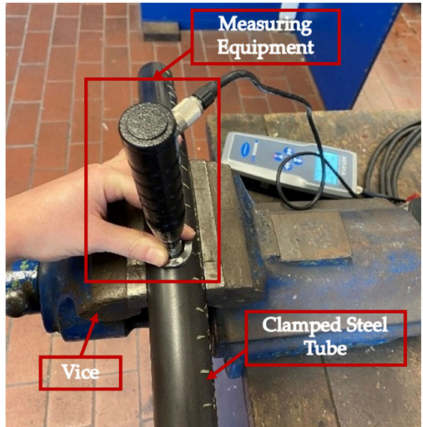
Figure 3. Method of conducting UCI hardness tests on bent steel tube (outside). UCI measuring equipment is used by hand to take hardness measurements of clamped steel